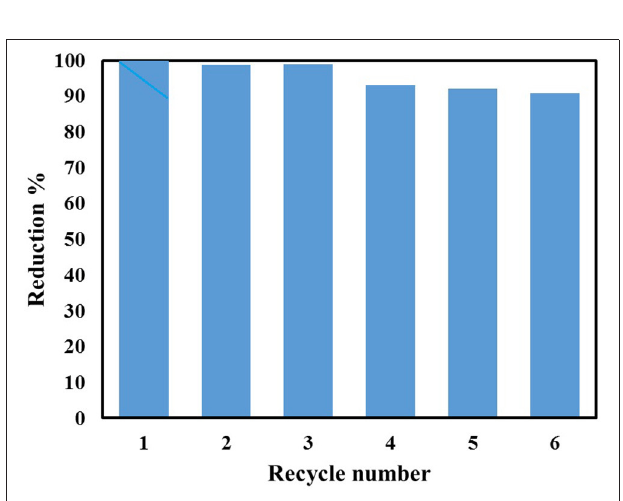
FIGURE 13 | Cycling performance of the 4%Ag/ CNT-graphene 400 catalyst for 4-NP reduction.